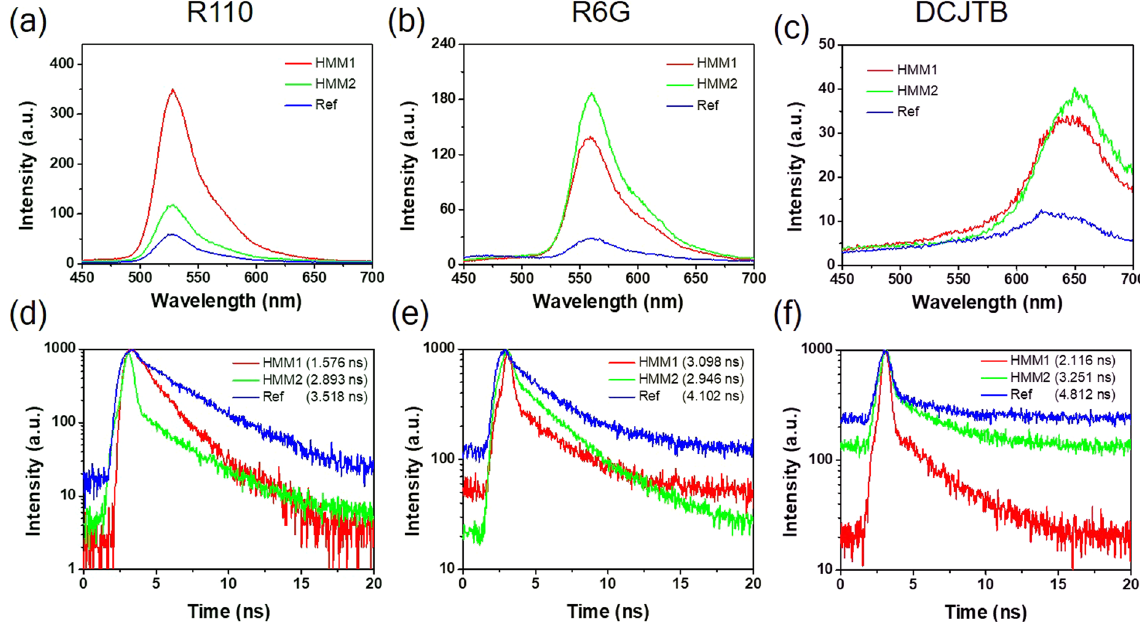
Figure 3. Photoluminescence spectra and the lifetime kinetics. ( a ), ( b ) and ( c ) are the measured photoluminescence spectra using 374 nm pulsed diode laser at the pumping energy density of 103 μ J/cm 2 for rhodamine 110 (R110), R6G and 4-(dicyanomethylene)-2- tert -butyl-6-(1,1,7,7-tetramethyljulolidin- 4-yl-vinyl)-4 H -pyran (DCJTB) dye molecules, respectively. ( d ), ( e ) and ( f ) are the corresponding lifetime